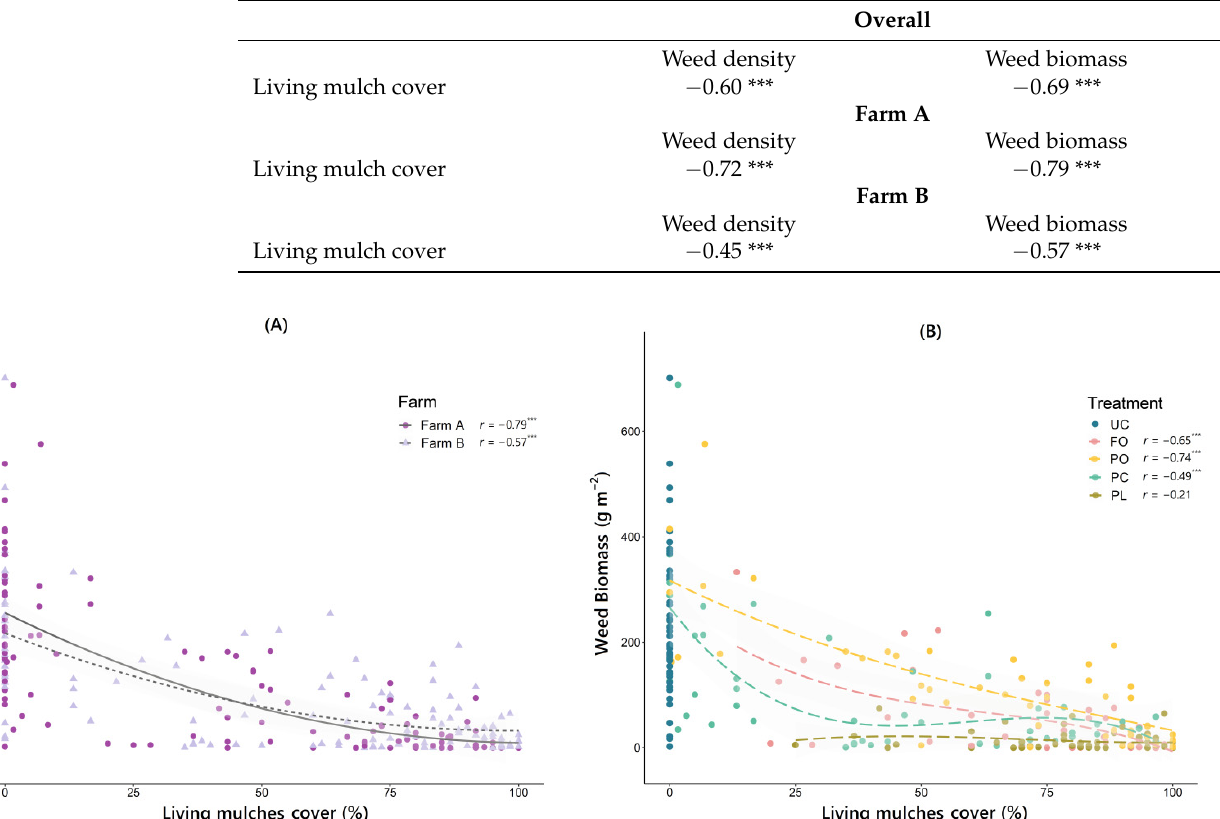
Table 5. Correlations between living mulch cover and weed density and weed biomass, calculated for the two farms (overall) and for each farm separately. The correlation value ( r ) was estimated using a Spearman correlation test. The significance level of the correlations is also indicated (*** p < 0.001).